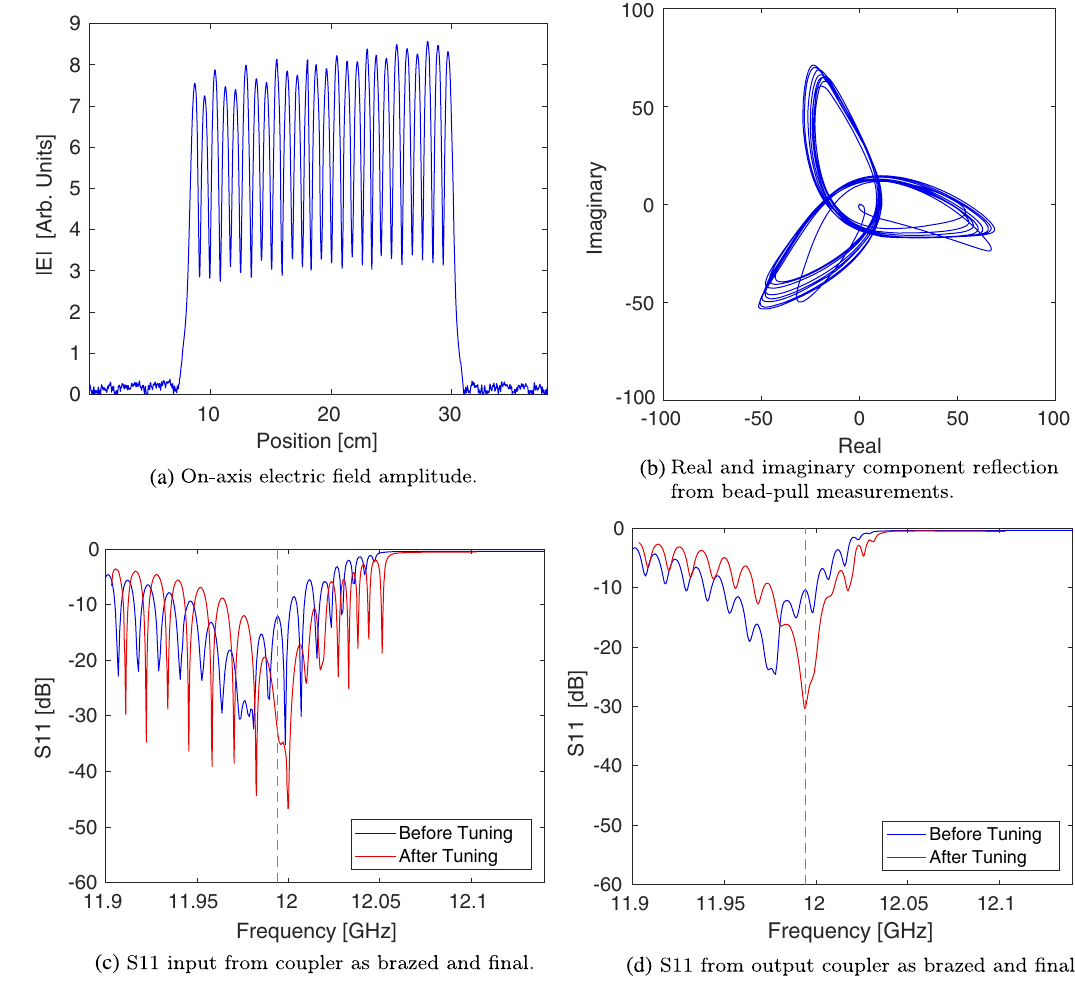
FIG. 9. S-parameters and results from bead-pull measurement of the brazed structure before and after tuning